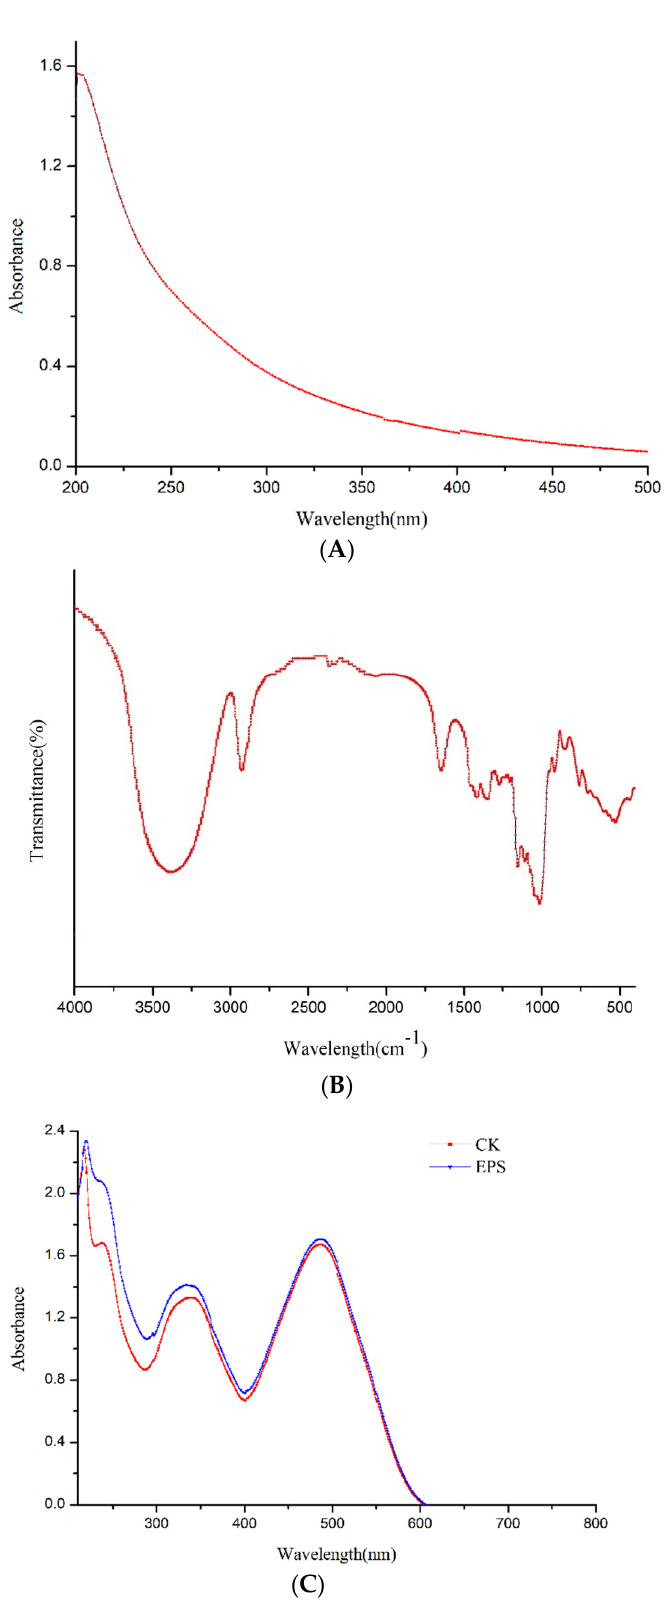
Figure 3. UV − Vis spectrogram ( A ), FT − IR spectrogram ( B ) and Congo red test analysis ( C ) of Figure 3. UV-Vis spectrogram ( A ), FT-IR spectrogram ( B ) and Congo red test analysis ( C ) of EPS-1 EPS − 1 from Lc. citreum 1.2461. from Lc. citreum